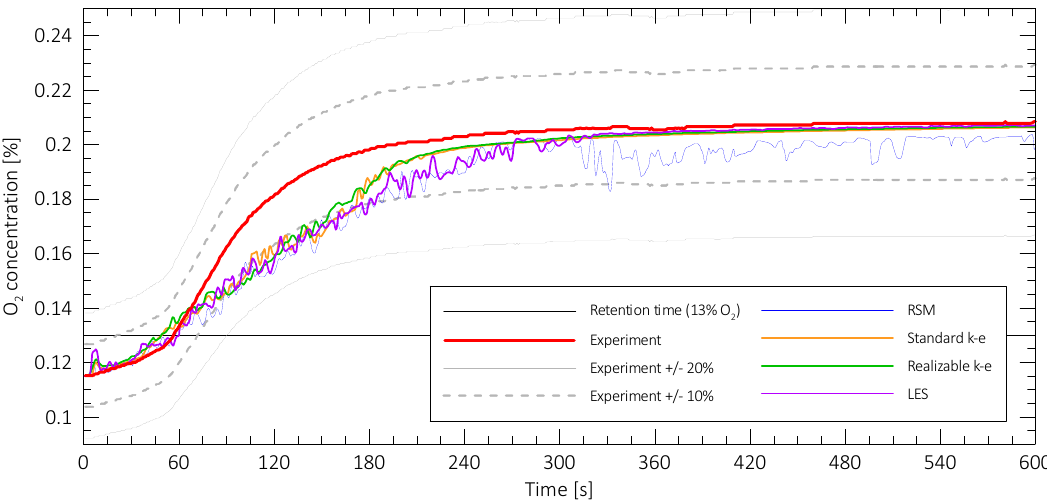
Figure 5. Changes in oxygen concentration (v/v) on the probe No. 1, indicating the end of the retention time during experimental tests and computational fluid dynamics (CFD) simulations, fire-extinguishing gas Ar 50% v/v and N 2 50% v/v.